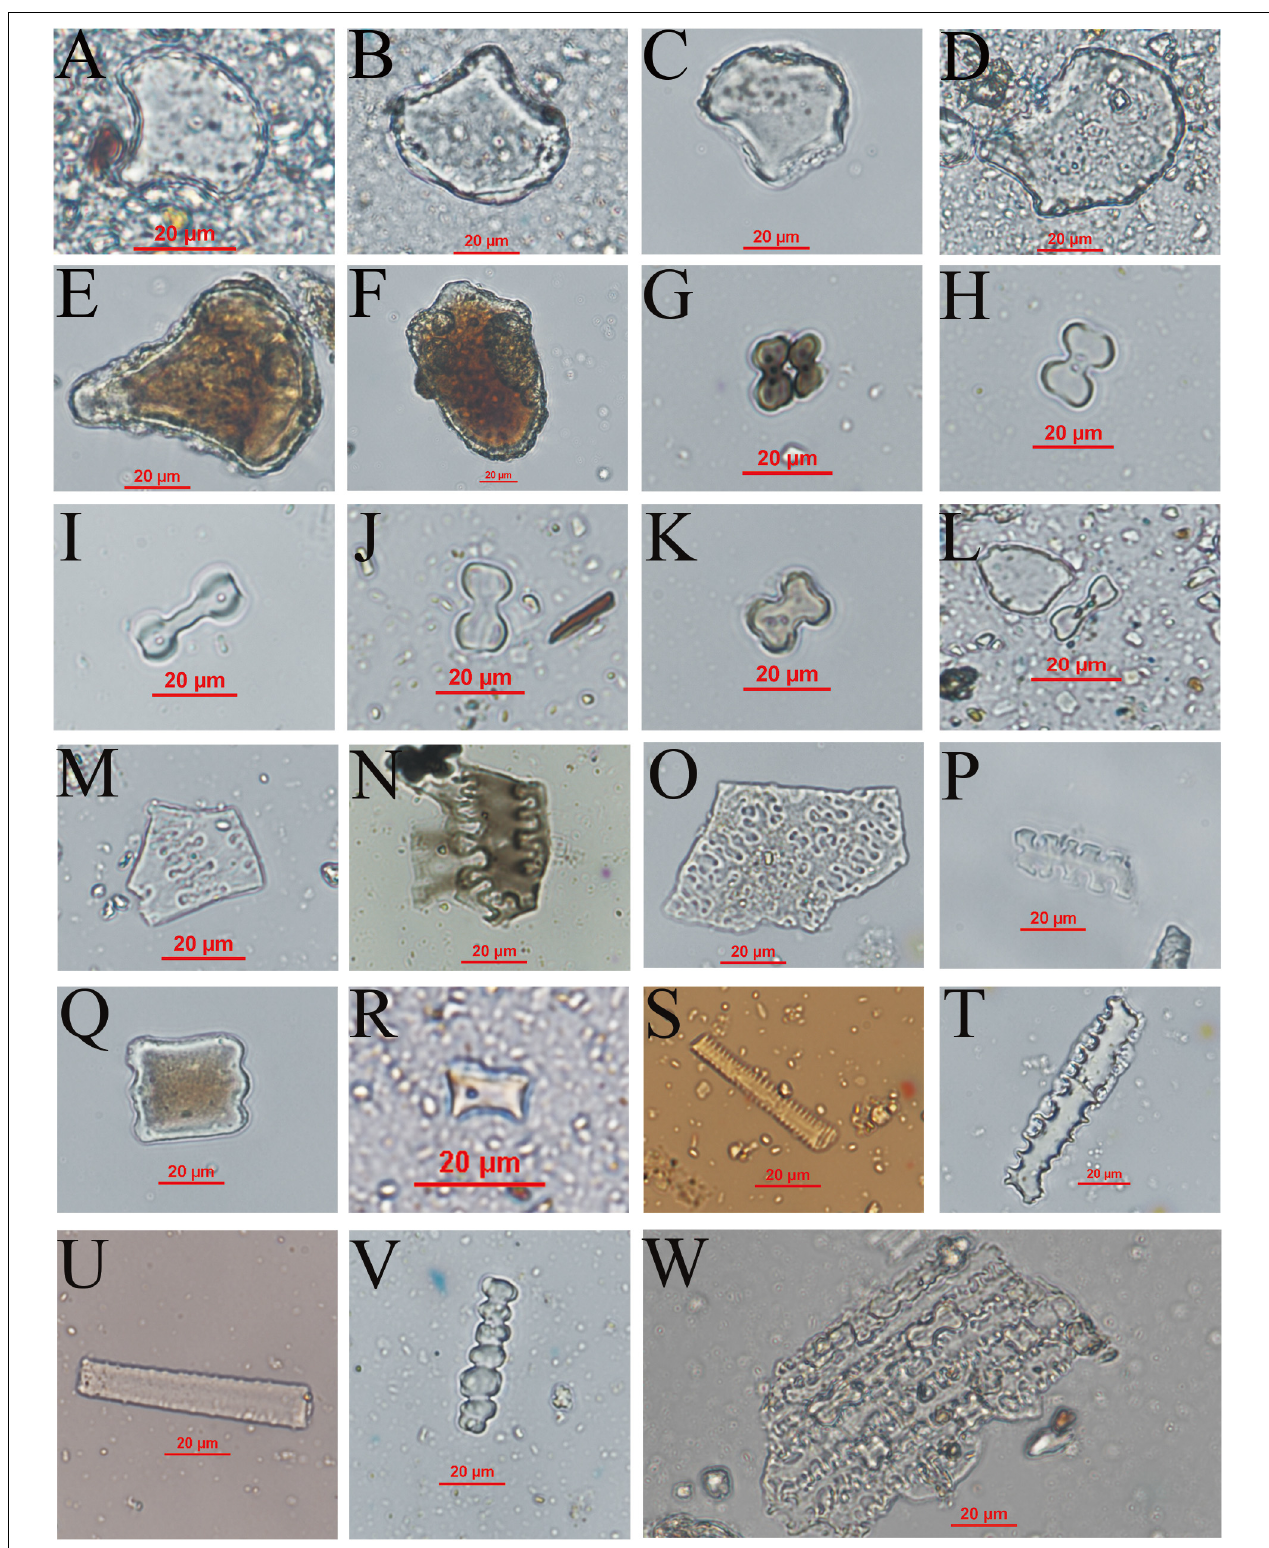
FIGURE 6 | Phytoliths recovered from Liangwangcheng dental residues. ( A – F , Bulliform cells; G – L , Bilobate short cells; M , broomcorn millet husk; N – P , foxtail millet husk; Q , Wavy–trapezoid; R , short cell; S , Rondel; T – V , Elongate; W , Bilobate short cells).